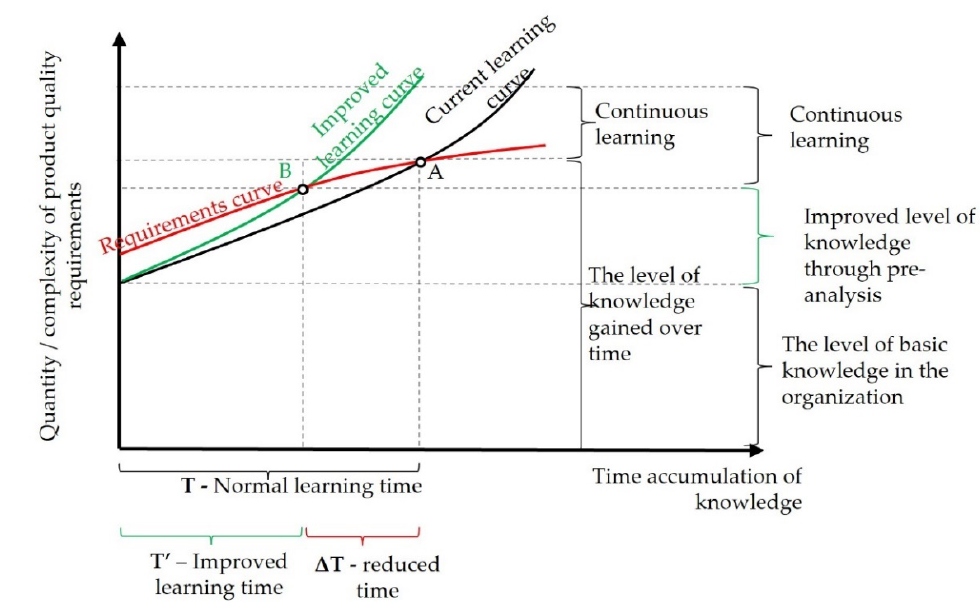
Figure 10. Interaction of product quality requirements with knowledge of industrial organizations.